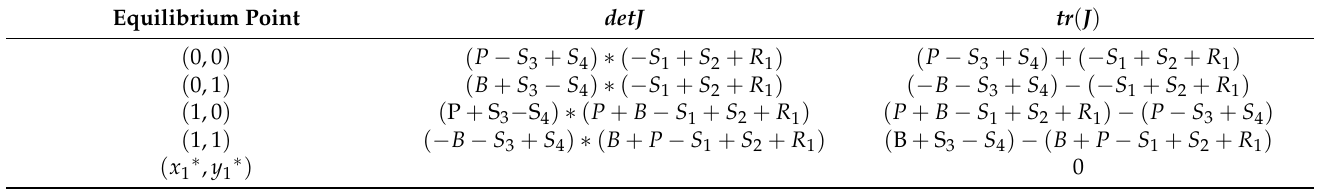
Table 3. An expression of the determinant and trace of each equilibrium point. Equilibrium